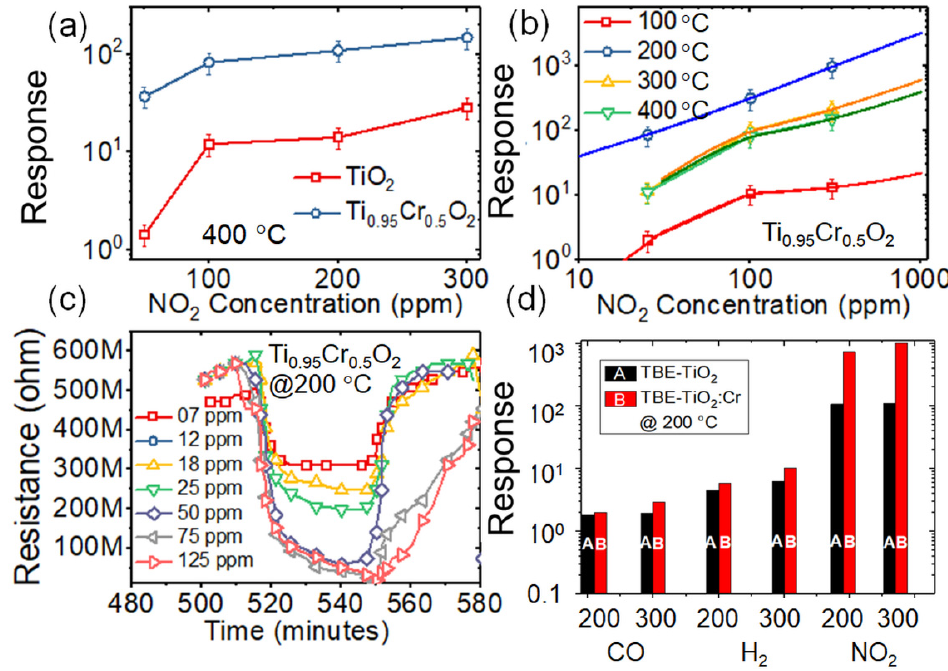
Figure 7. The comparative sensing performance of the Pt/TiO 2 /Pt and Pt/Cr-TiO 2 /Pt ( a ) sensors measured at 400 ° C and annealed at 800 ° C. Further sensing analysis of Pt/Cr-TiO 2 /Pt sensors at various temperatures 100 ° C, 200 ° C, 300 ° C, and 400 ° C ( b ), the dynamic responses of the Pt/Cr- TiO 2 /Pt sensor measured at 200 ° C toward low concentrations (7, 12, 18, 25, 50, 75, and 125 ppm) of NO 2 gas ( c ), the selectivity of the Pt/Cr-TiO 2 /Pt sensor toward NO 2 again H 2 , and CO reducing exhaust gases ( d